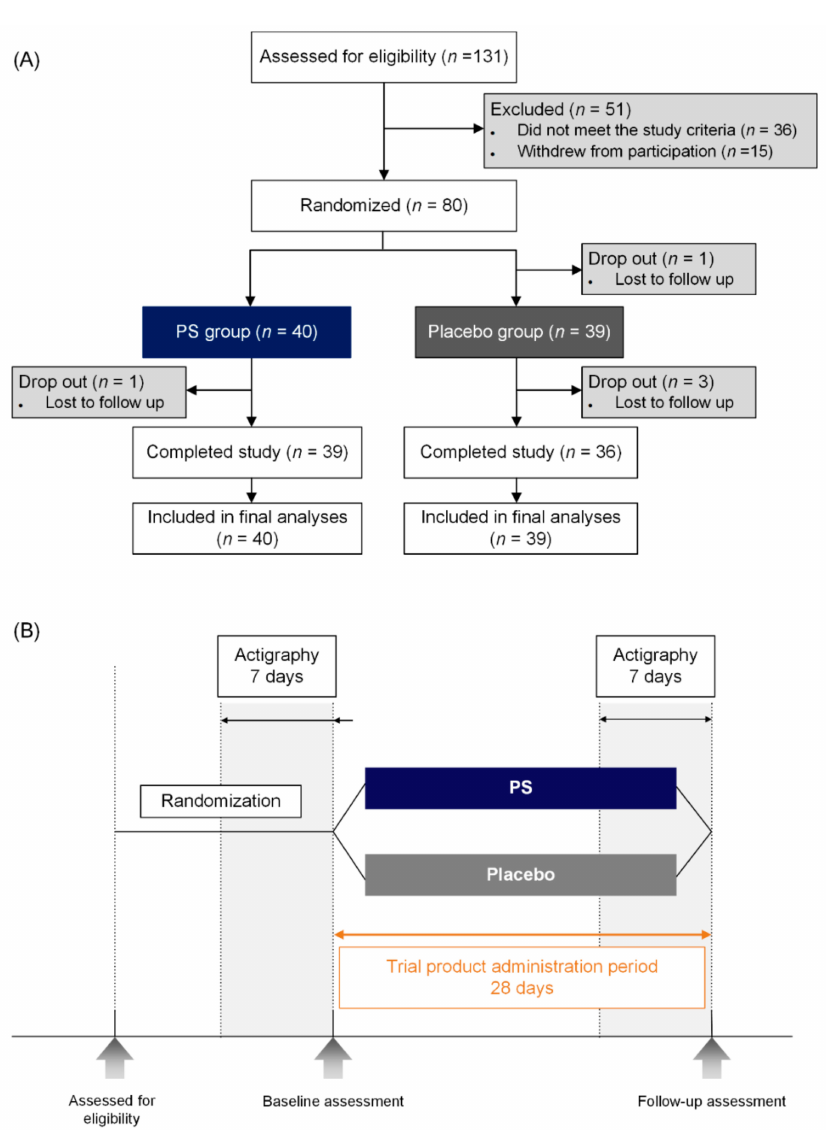
Figure 1. ( A ) Flowchart of the clinical trial. Eighty participants were enrolled and randomly assigned into one of two groups: 40 participants received placebo (Placebo group) and 40 received PS (PS group). ( B ) Study procedure. After randomization, the baseline evaluation was performed, which included the assessment of the Athens Insomnia Scale (AIS), objective sleep measures acquired using actigraphy, and multimodal brain MRI data. A follow-up visit was scheduled upon completion of the administration period. PS; Polygonatum